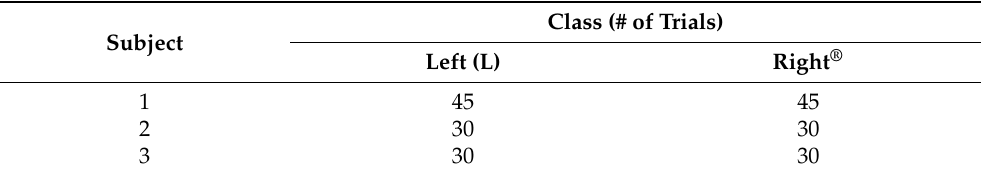
Table 3. The C3D3a_2C dataset composed of three subjects and the predefined number of experimen- tal